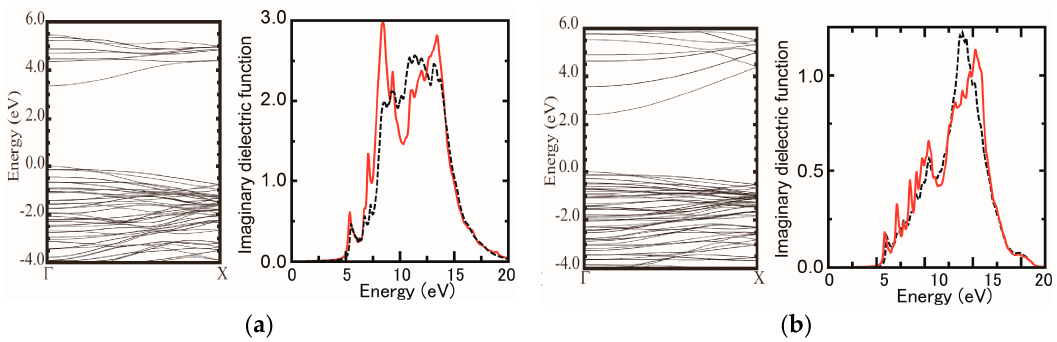
Figure 37. Calculated band structure and imaginary part of dielectric function of ( a ) GaN and ( b ) ZnO NWs with diameter of 1.3 nm. Energies are measured from the highest occupied state. Solid and dashed lines in dielectric function represent the imaginary part of dielectric function polarized along the nanowire axis and that in the orthogonal plane.